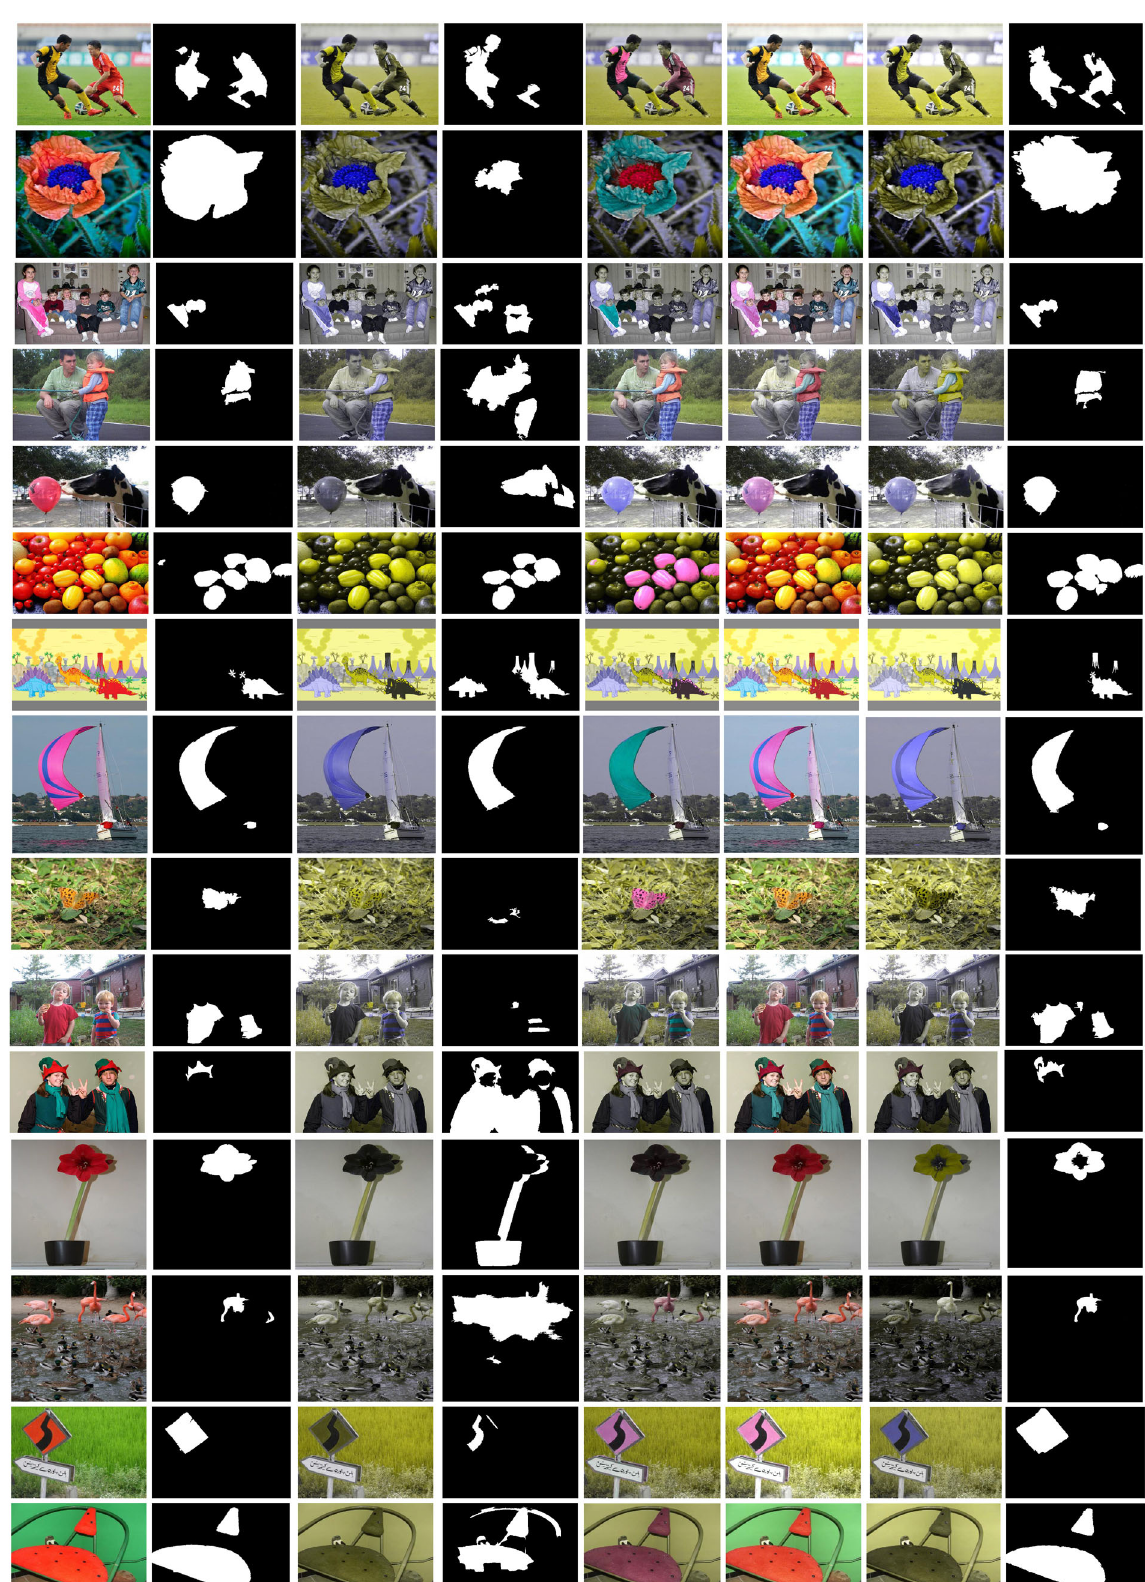
Fig. 8 Some examples of saliency-driven image correction for protanopia